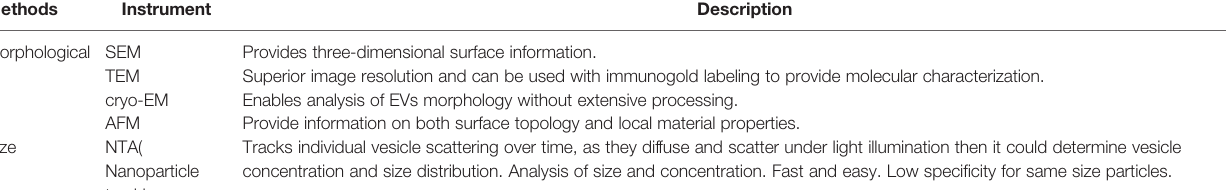
TABLE 2 | Summary of exosome characterization techniques.